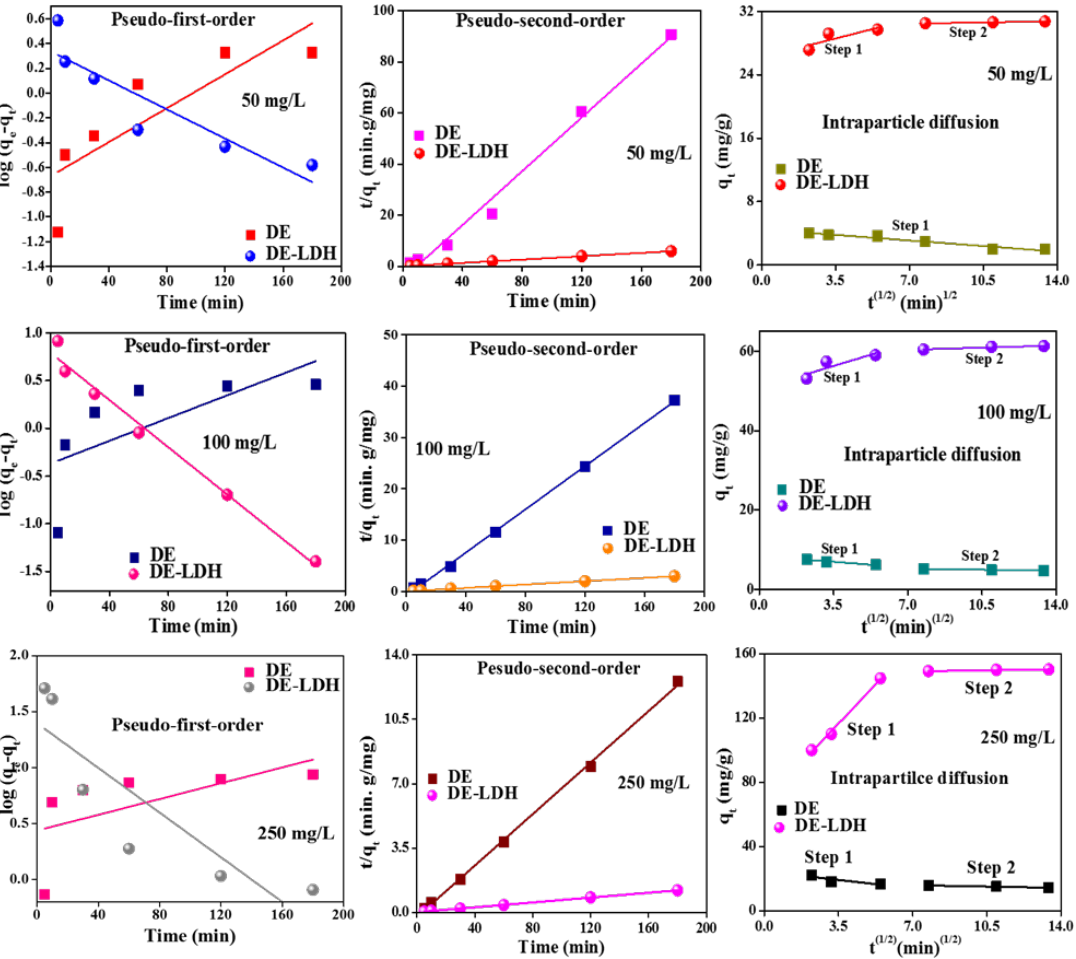
Figure 8. Adsorption kinetic plots for different concentration of CR onto DE and DE-LDH. Table 3. Adsorption kinetic values for adsorption of CR onto DE and DE-LDH.